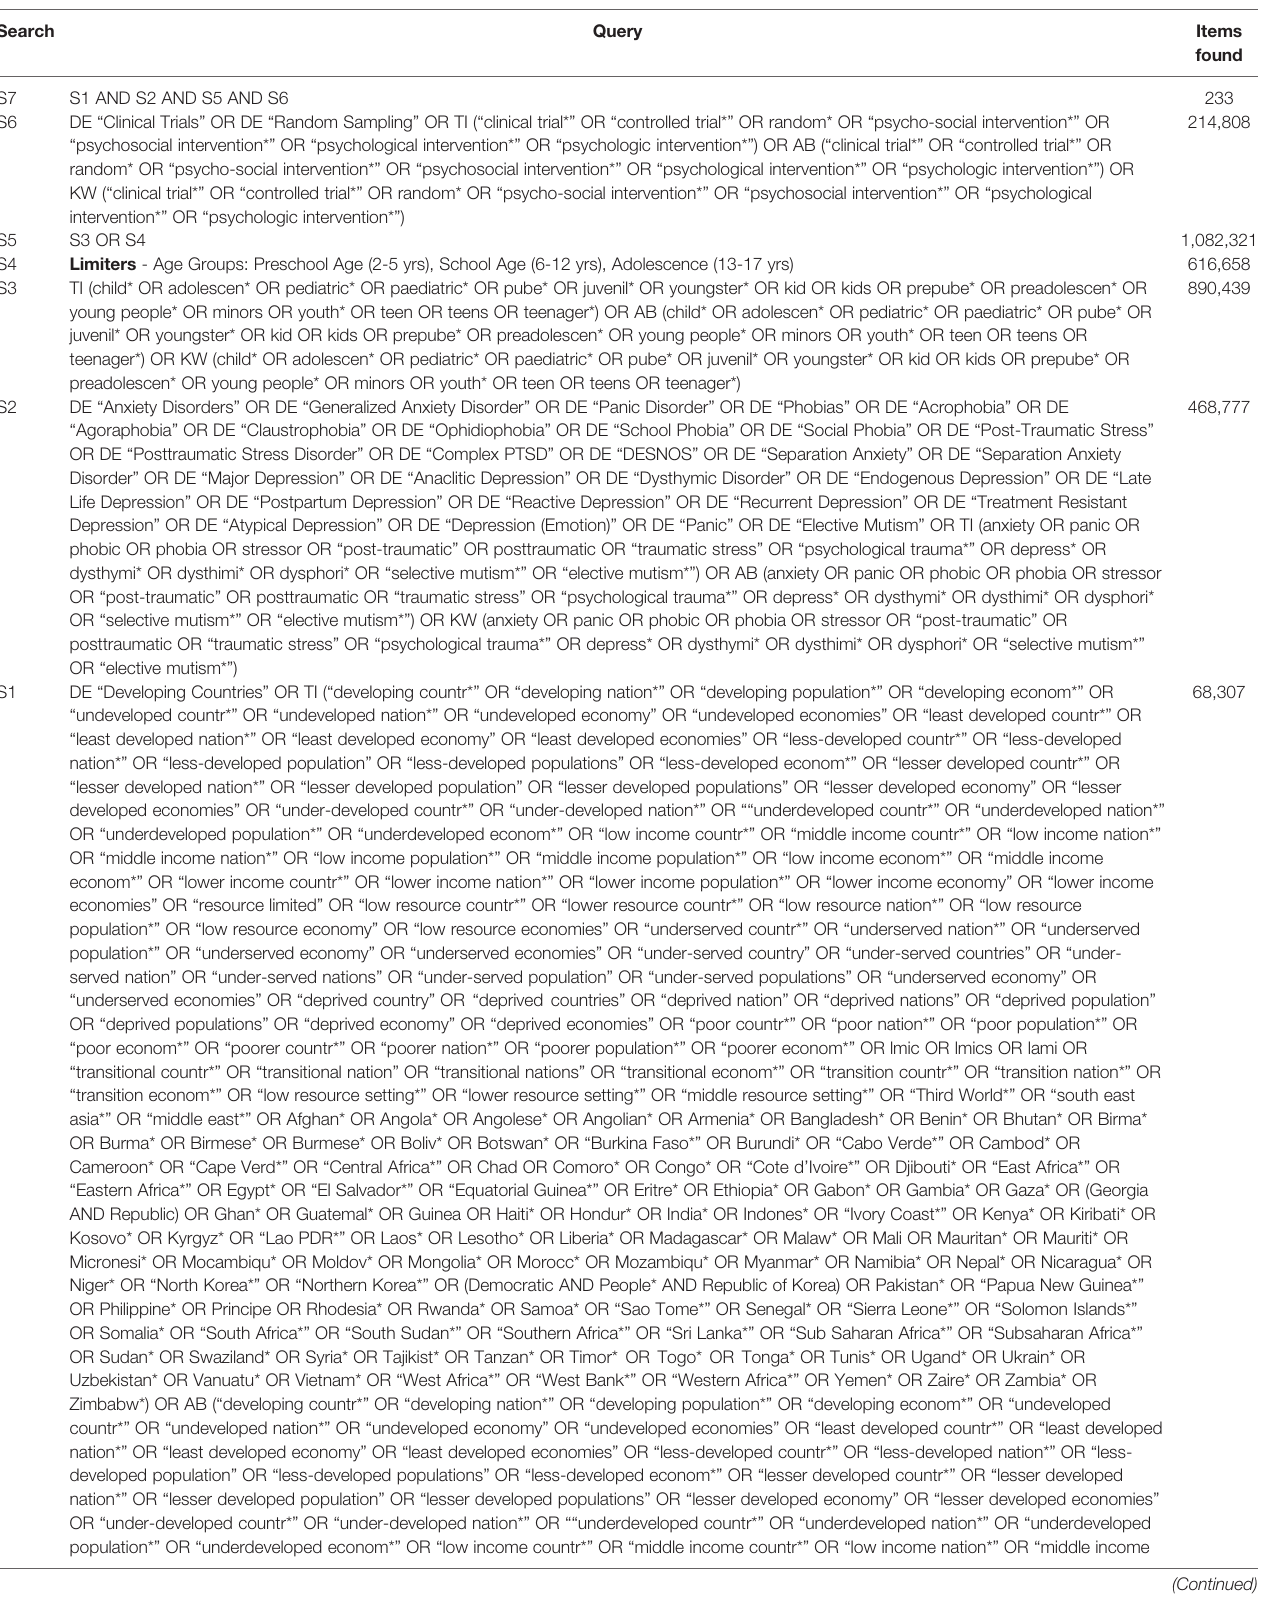
TABLE 4 | Search string EBSCO/PsycINFO session results (14 Dec